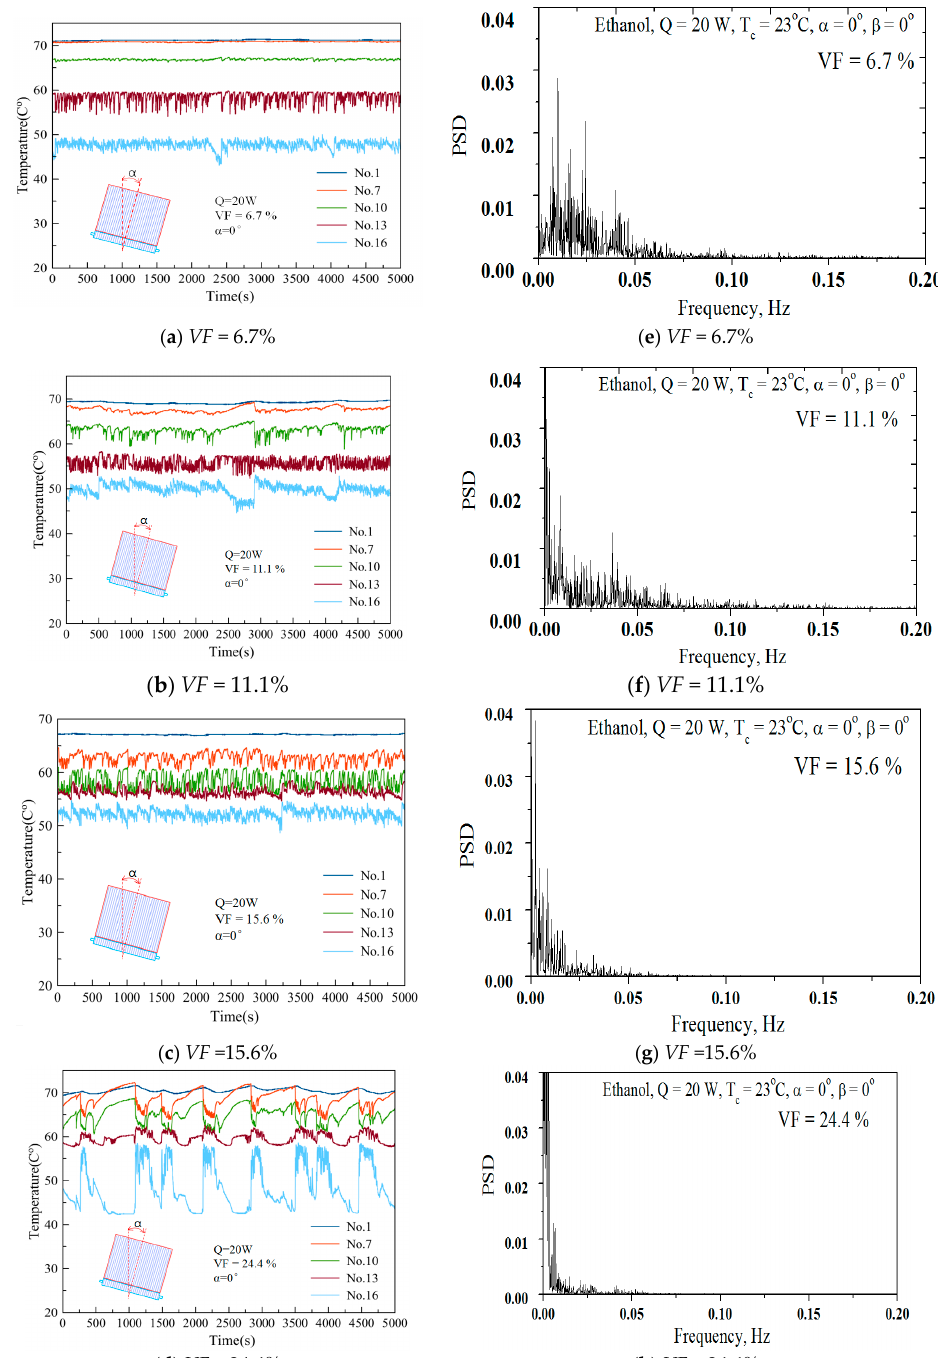
Figure 7. Transient Temperature Variation and FFT PSD Distribution (#No. 13), Q = 20 W.